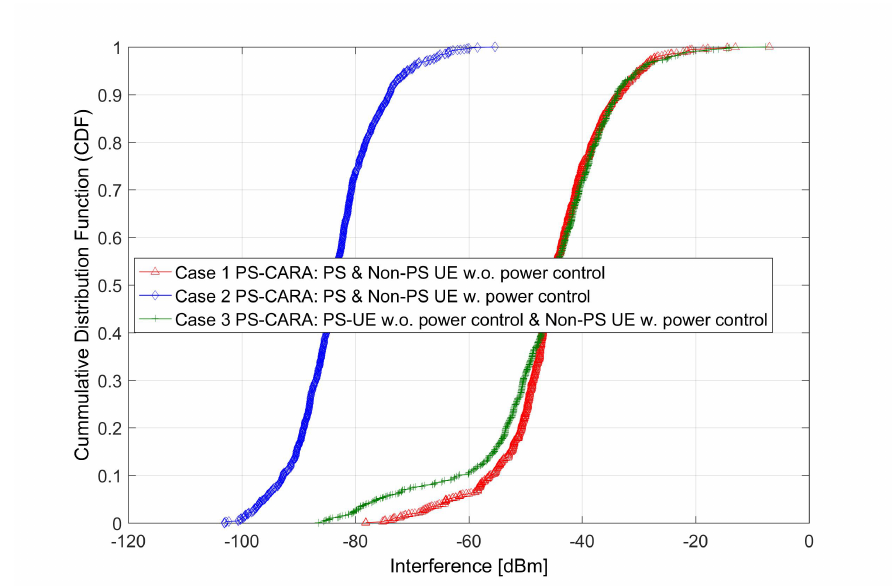
Figure 7. User received interference under the proposed PS-CARA